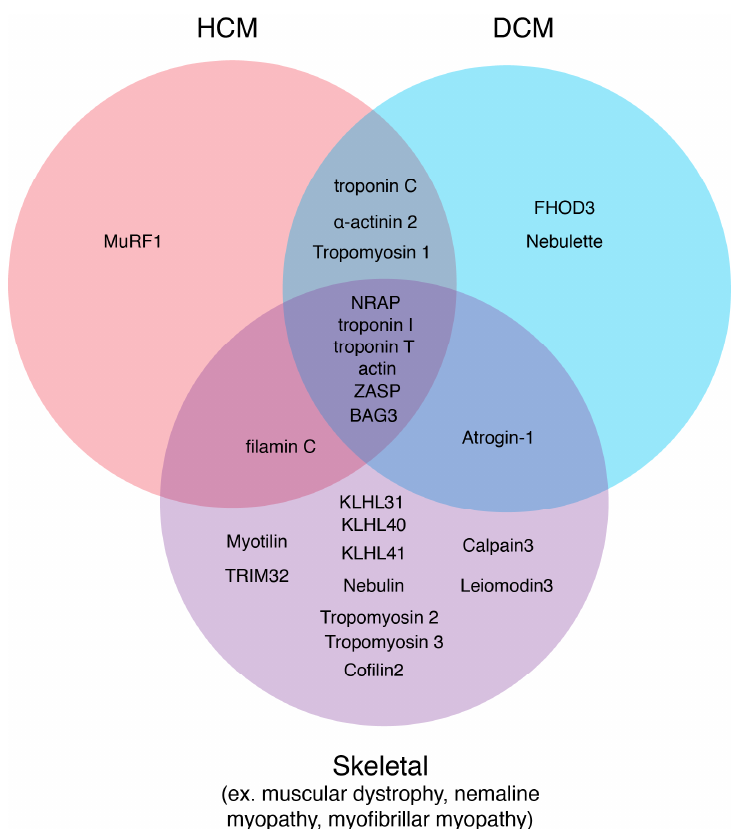
Figure 4. Sarcomere thin filament disease candidates. Using the online database, Online